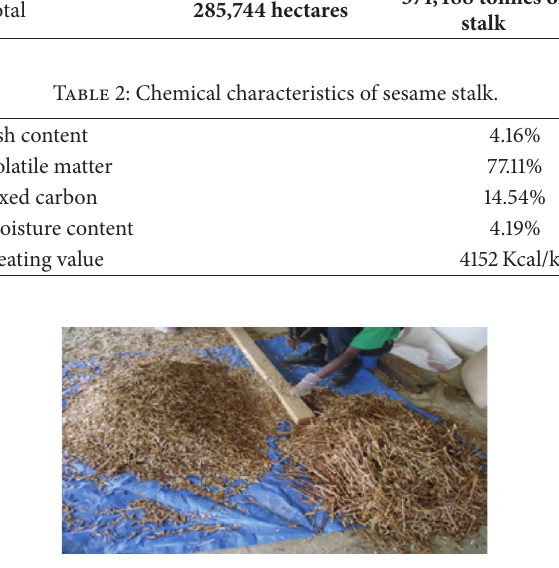
Figure 2: Sesame stalk being